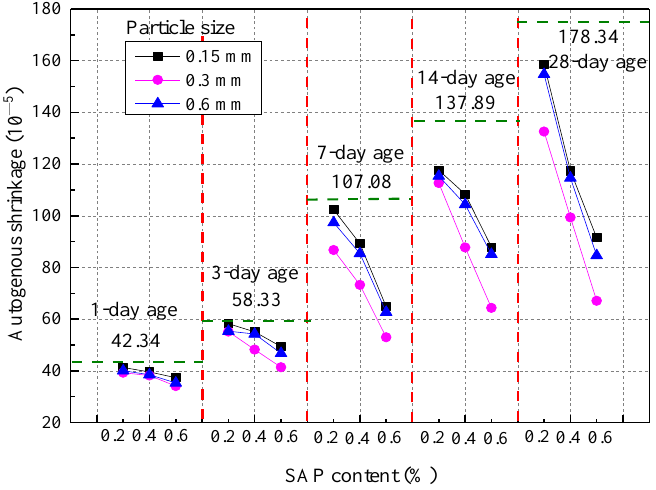
Figure 12. Autogenous shrinkage of concrete at different ages.